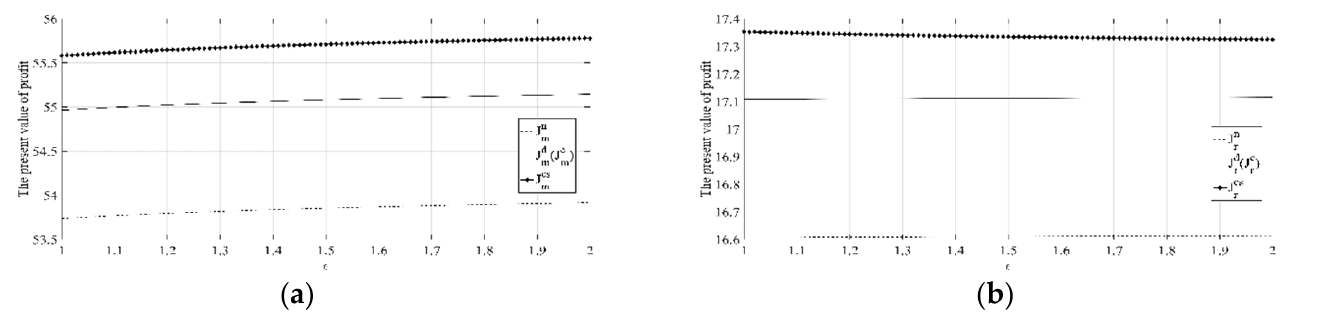
ε on the manufacturer’s profit. ( b ) The effect of